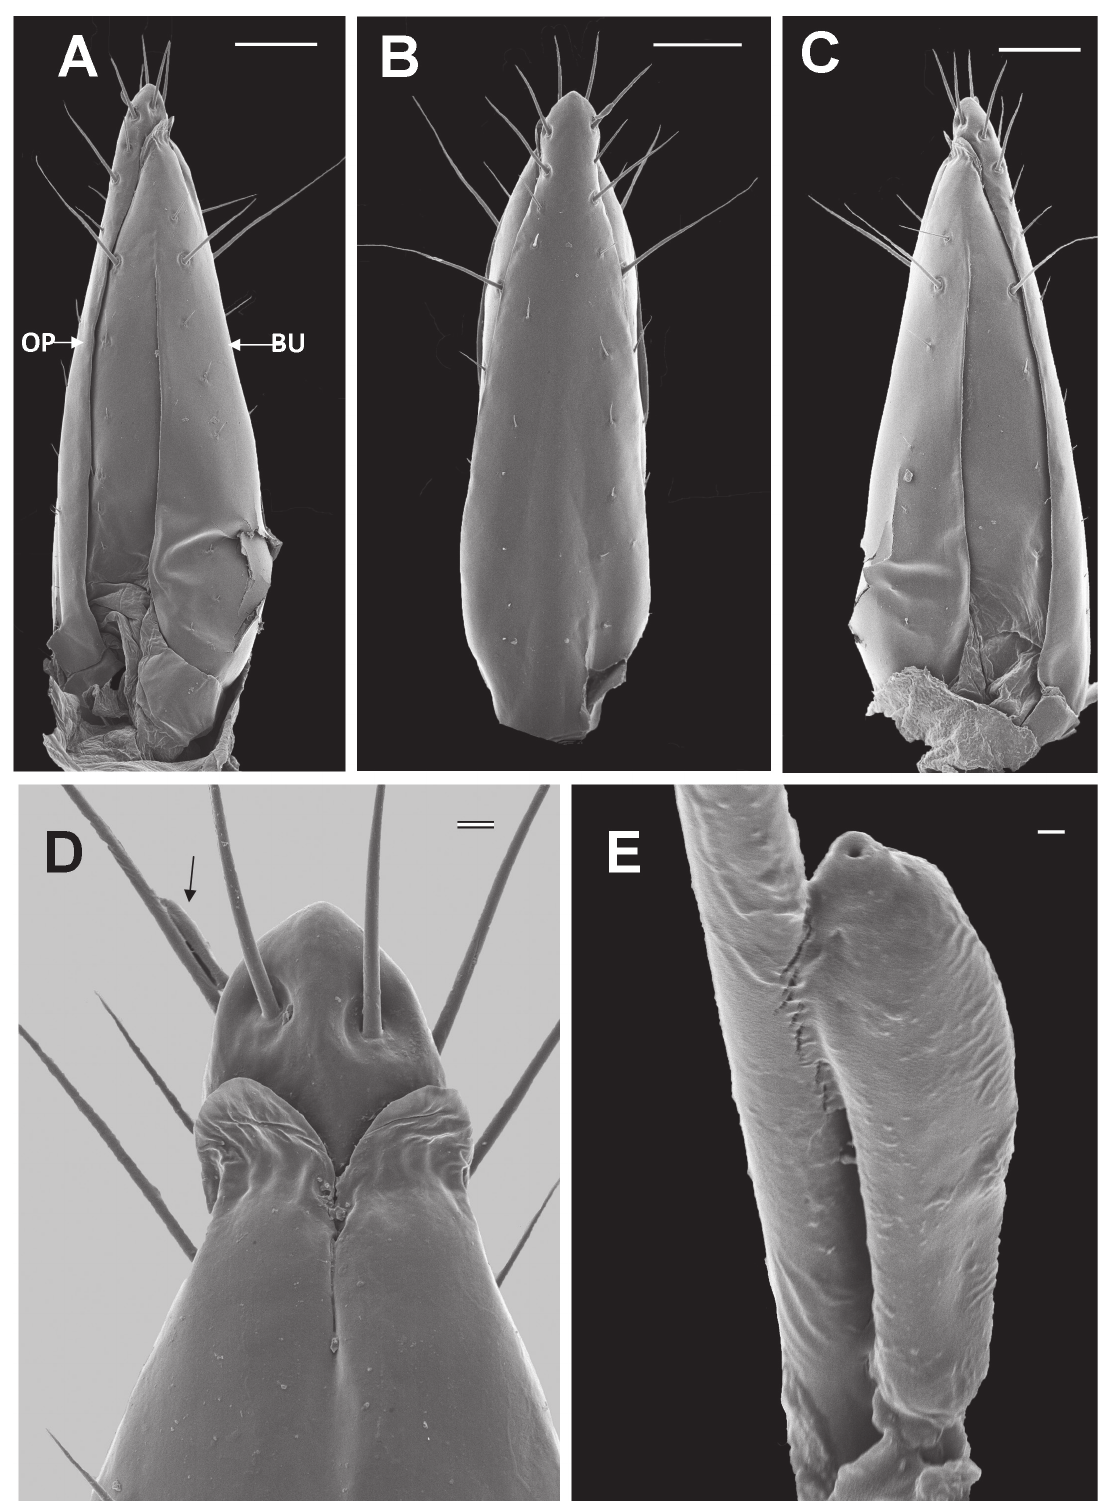
Fig. 9. Koiulus interruptus gen. et sp. nov., paratype, ♀, from upper course of river Ko , right vulva. A . Lateral view. B . Anterior view. C . Mesal view. D . Tip, posterior view; arrow points to unknown structure. E . Unknown structure from opercular seta. Abbreviations: BU = bursa; OP = operculum. Scale bars: A–C = 0.1 mm; D = 0.01 mm; E = 0.001